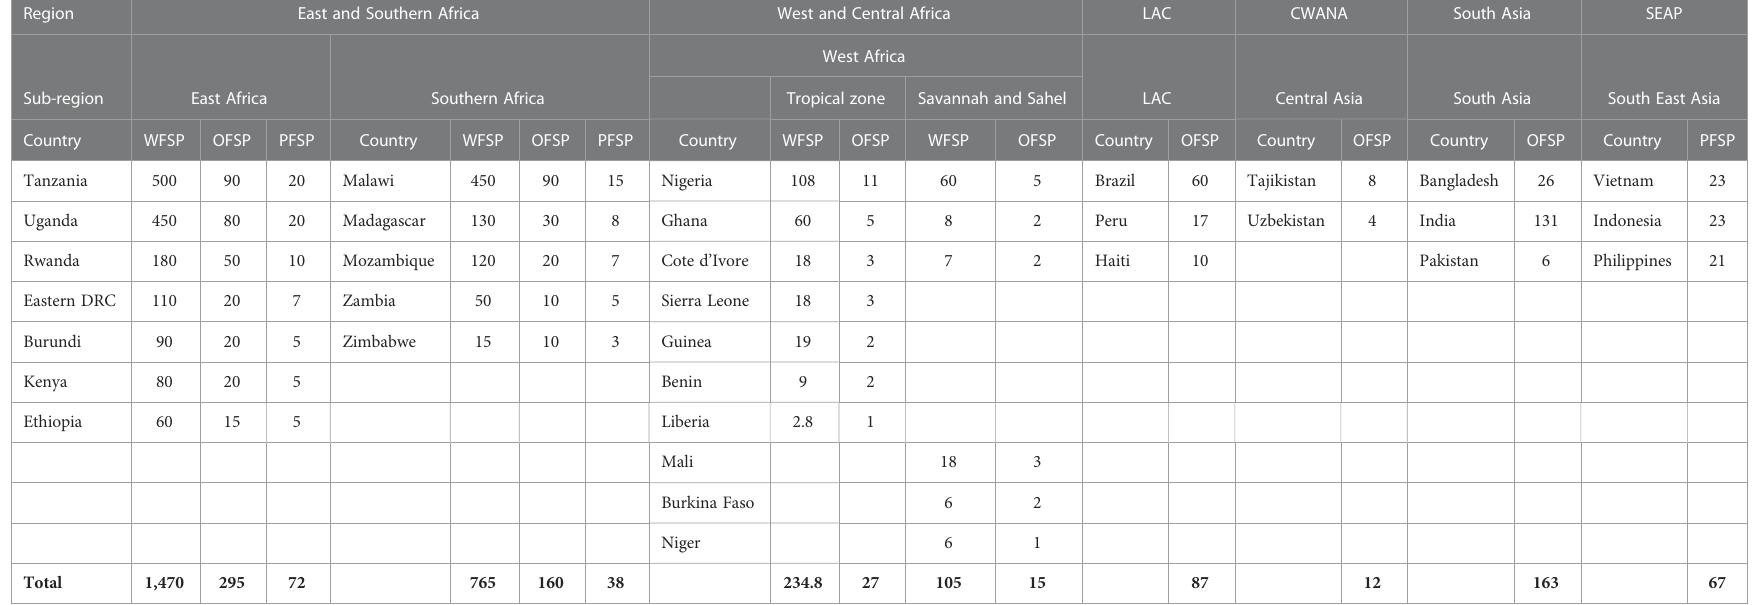
TABLE 1 Hectares targeted in the sweetpotato market segments. Region